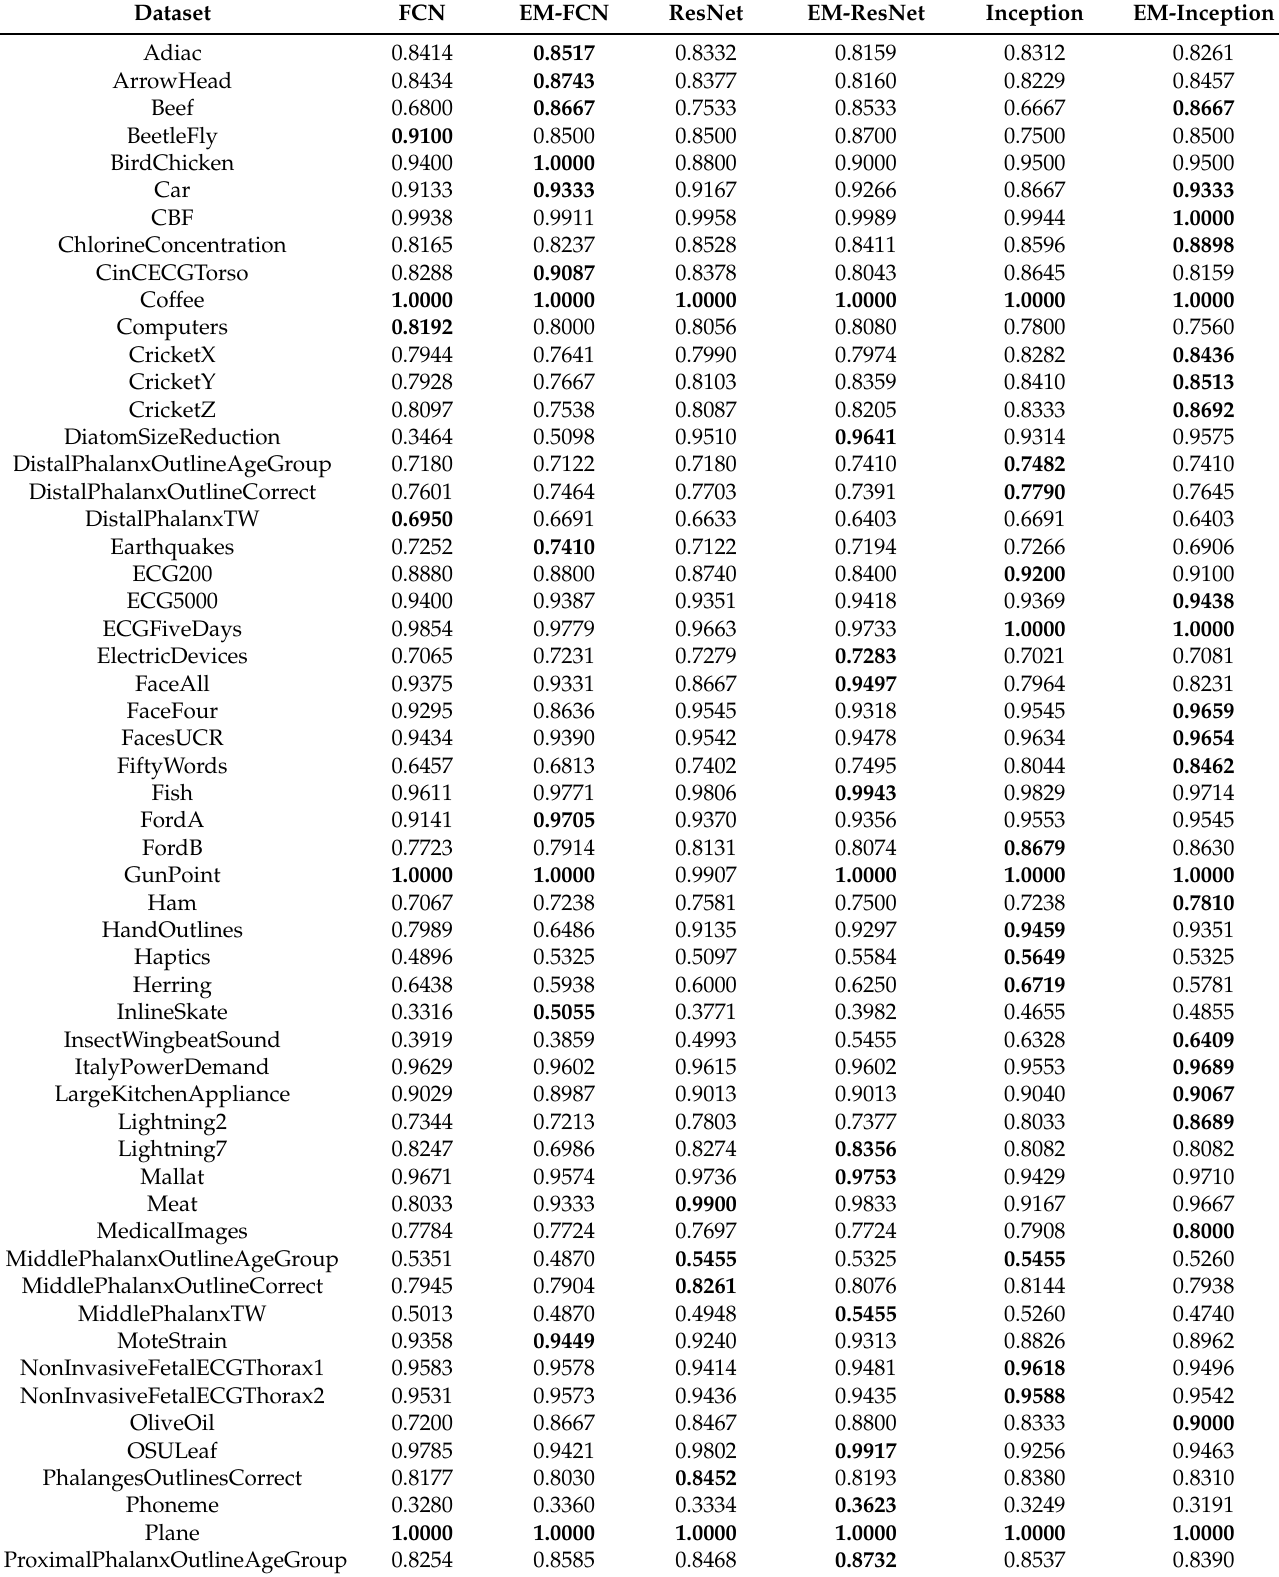
Table 1. Evaluation metrics involving 85 time series datasets on the UCR archive .The values before the last four rows represent the accuracy ratios comparison on each dataset and the last four rows represent the Number of Win, AVG-AR, AVG-GR and MPCE comparison between different